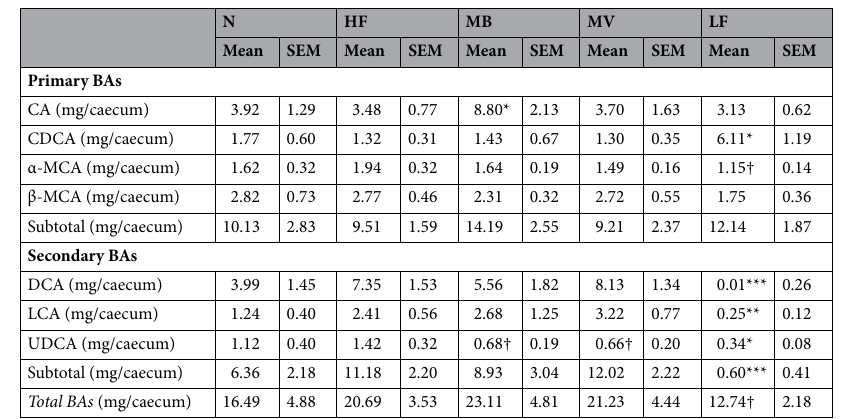
Table 1. Caecal amounts (mg/caecum) of bile acids (BAs). Conventional rats (N) fed a high-fat diet and ApoE-/- rats fed either a low-fat diet (LF), a high-fat diet as it is (HF) or supplemented with 1% monobutyrin (MB) or monovalerin (MV). Data are shown as means and their standard errors (SEM). Significant differences compared with the HF group: *, p < 0.05; **, p < 0.01; ***, p < 0.001; †, 0.05 ≤ p ≤ 0.1. Cholic acid (CA), chenodeoxycholic acid (CDCA), deoxycholic acid (DCA), lithocholic acid (LCA), ursodeoxycholic acid (UDCA), α-muricholic acid (α-MCA) and β-muricholic acid